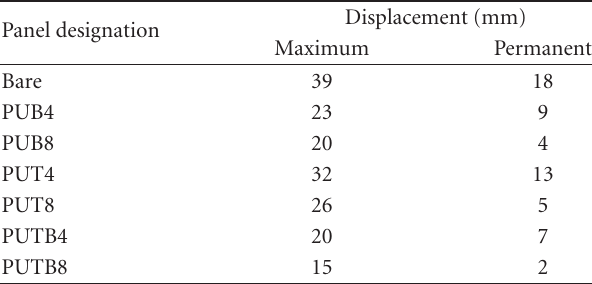
Table 2: Maximum and permanent displacements recorded in the panels due to the blast